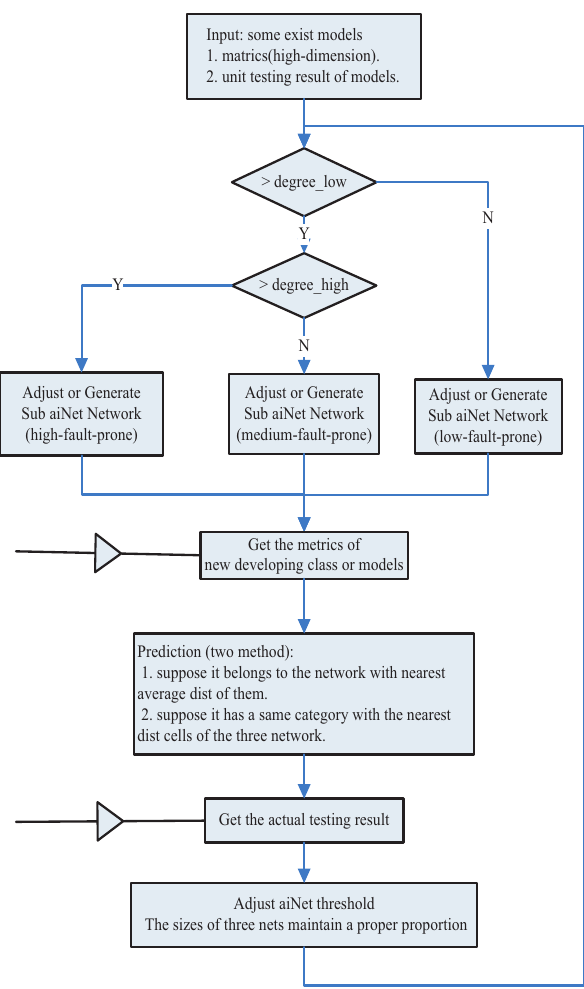
Fig. 3. Prediction Framework Flowchart based on aiNet.